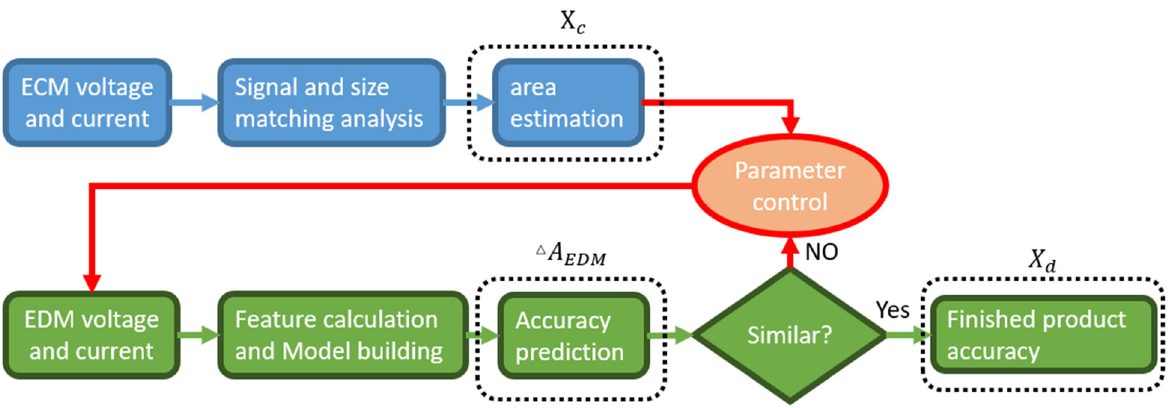
Figure 1. Matching process for precise composite electrical machining.